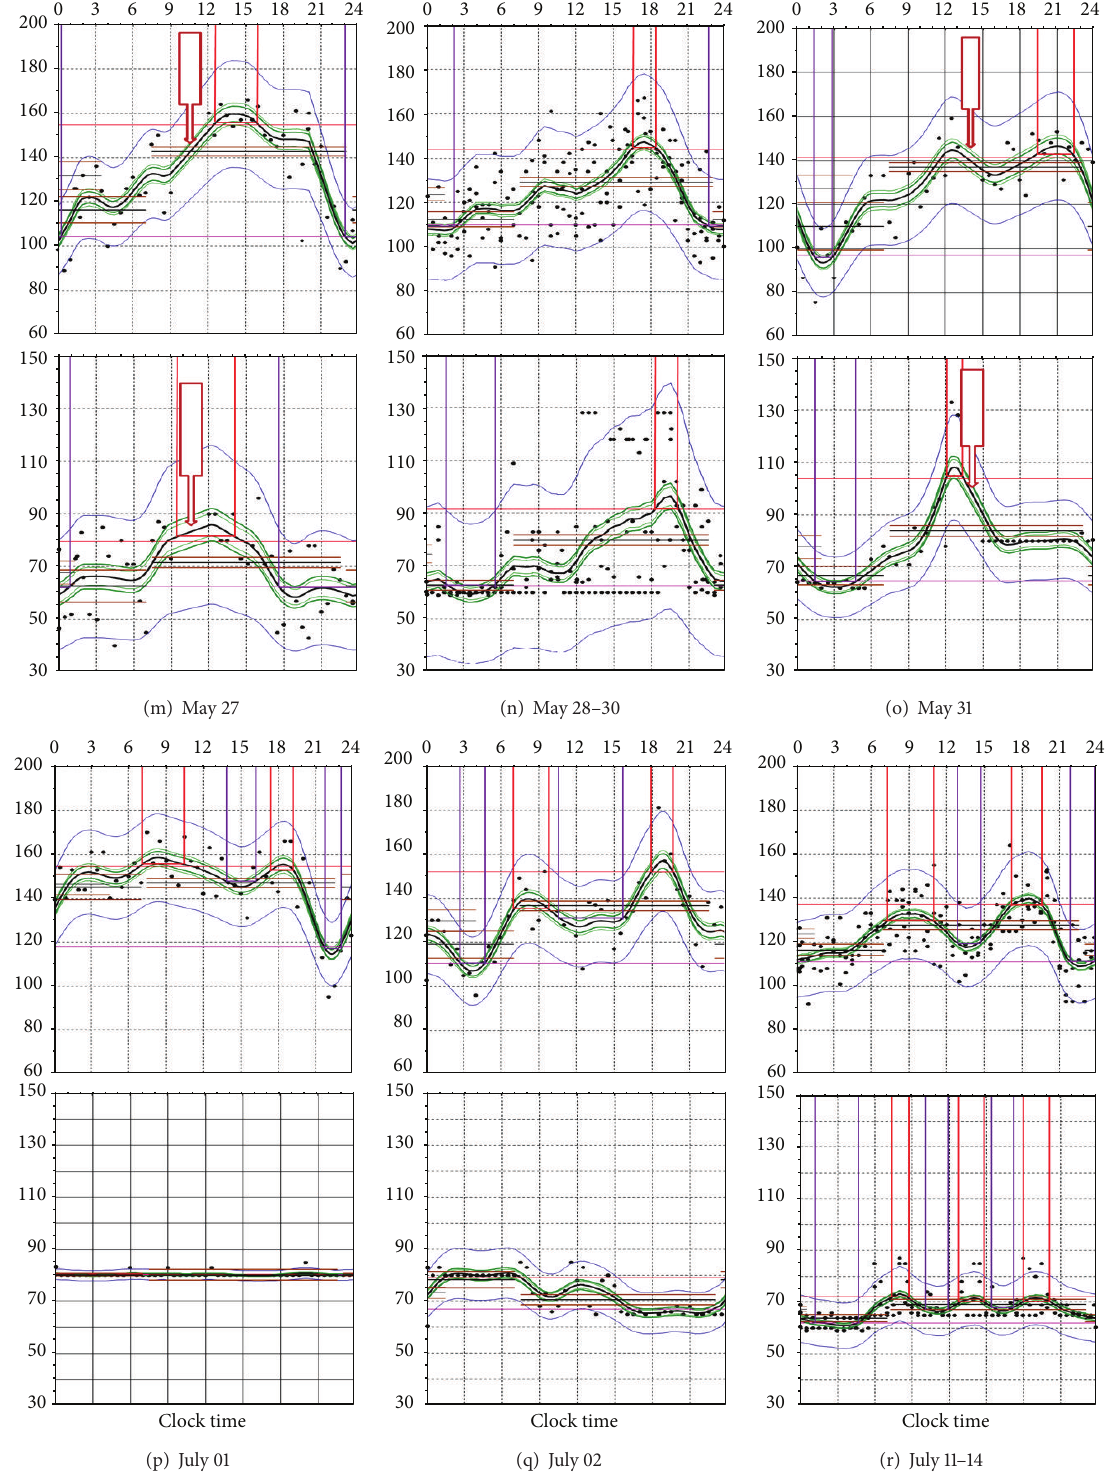
Figure 2: Daily profiles of systolic blood pressure (SBP), and heart rate (HR) before heart failure and during its treatment. ((a)–(r)): Subsequent stages of development. Upper row: SBP; lower row: HR. Abscissa: clock time; ordinates: variable’s value (SBP: mmHg; HR: beats/min).Blackdots:separaterecords,Blackcurve:approximationoftheprocess,Greenlines:95%confidencelimits(CL)ofapproximation, blue lines: 95%CL of records population, Horizontal brown lines: middle night-time and middle day-time variable levels and Vertical red lines: positions of top and statistically significant elevations during the 24-hour span (99%CL-s). Vertical violet lines: positions of bottom and statistically significant decreases during the 24-hour span and their